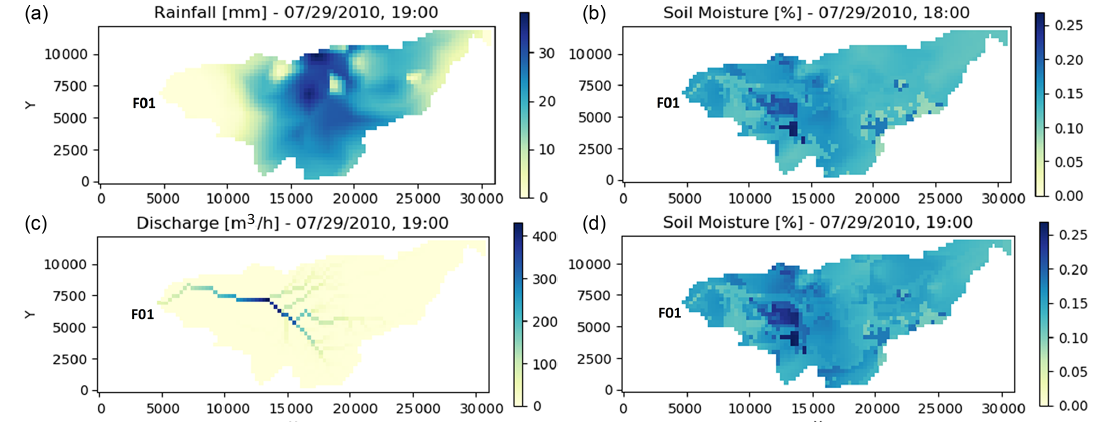
Figure 9. Spatio-temporal visualisation of the model process simulation at WGEW: (a) the rainfall event, (b) soil moisture prior to the rainfall event, (c) the ephemeral stream for the rainfall event, and (c) soil moisture after the rainfall event. The x and y axis distance units are in